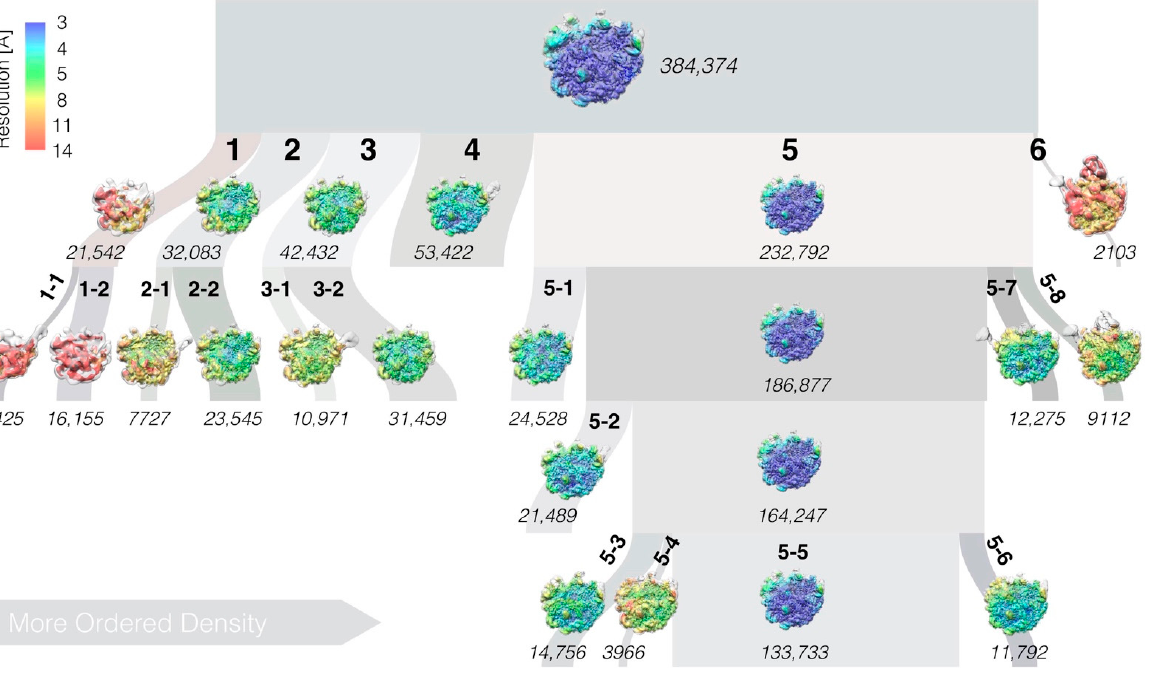
Figure 1. Single-particle reconstruction and hierarchical classification of LiCl core particles. The widths of the branches in the diagram reflect the number of particle images (italic font) in each class (bold font). Classes are sorted from left to right, approximately according to the amount of ordered density. Images show the reconstructions in “crown view” with the L1 protuberance to the left and the L7/L12 stalk to the right (cf. Figure S6 for additional views).